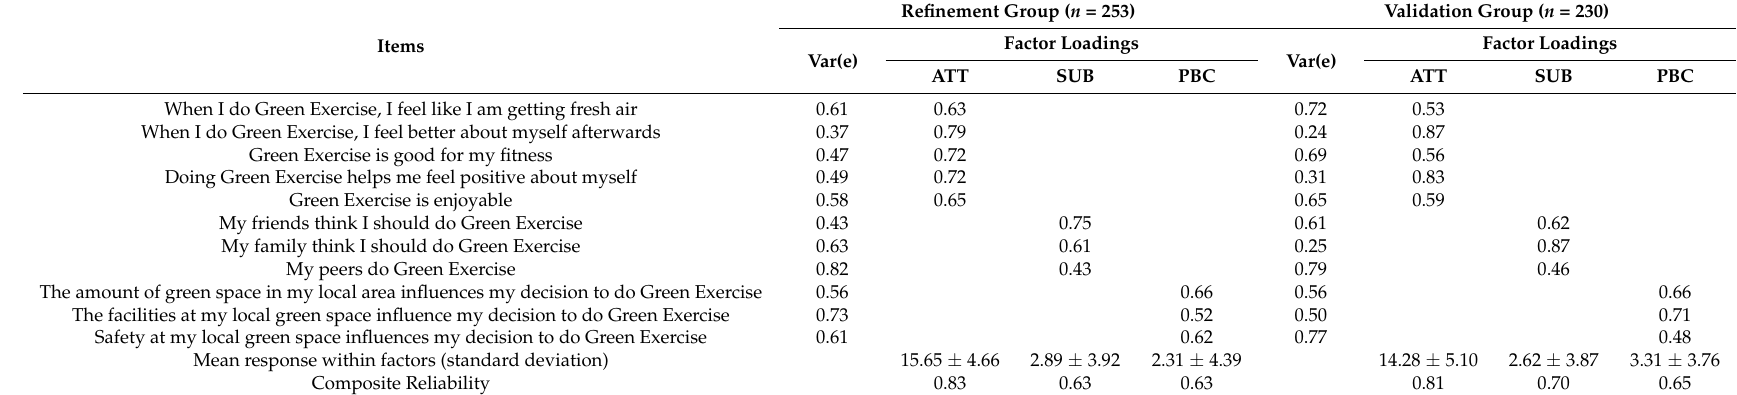
Table 4. Descriptive statistics, measurement error variances, factor loadings and composite reliabilities for the indirect beliefs about green exercise (BAGE-ID). Refinement Group ( n = 253) Validation Group ( n = 230) Factor Items Var(e)